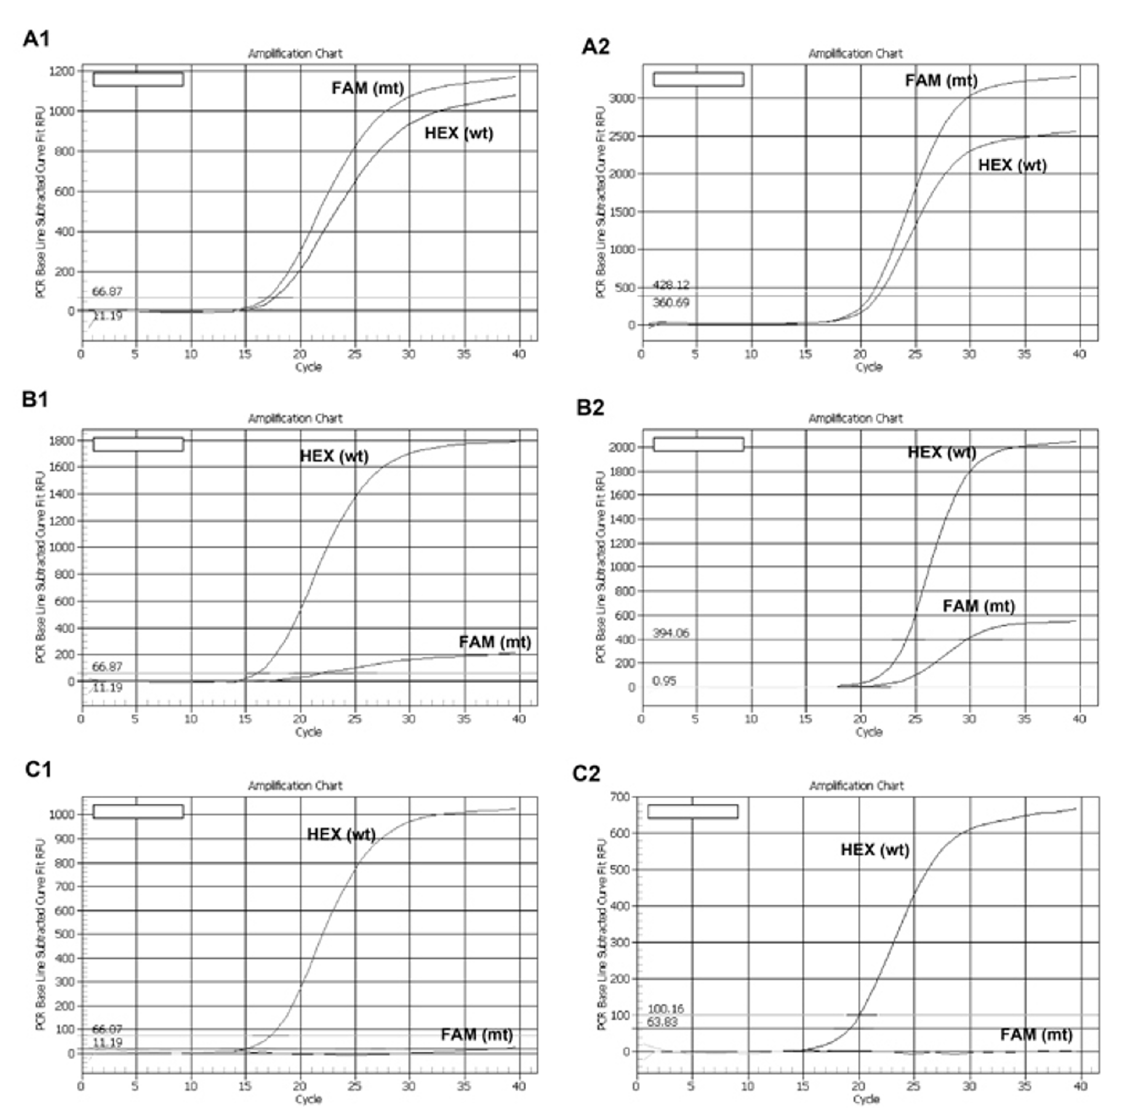
Figure 2. Backgrounds and signals of FAM and HEX in quantification of mutants and wild type alleles. A1-2: Amplification chart of FAM and HEX signals in a strong positive sample (72%) using Taqman LNA and non-LNA probes; B1-2: Amplification chart of FAM and HEX signals in a weak positive sample (9%) using Taqman LNA and non-LNA probes; C1-2: Amplification chart of FAM and HEX signals in normal sample using LNA and non-LNA